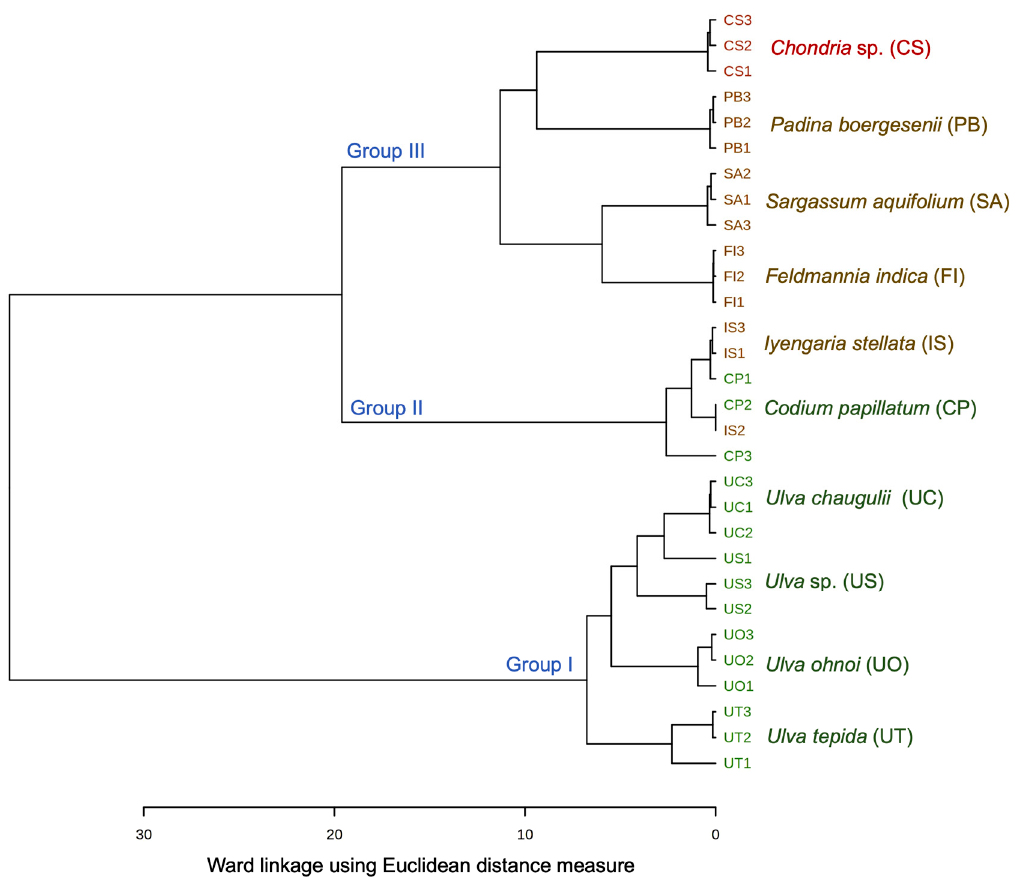
Figure 1. Dendrogram obtained from hierarchical clustering of seaweeds samples using Ward linkage with Euclidean distance.